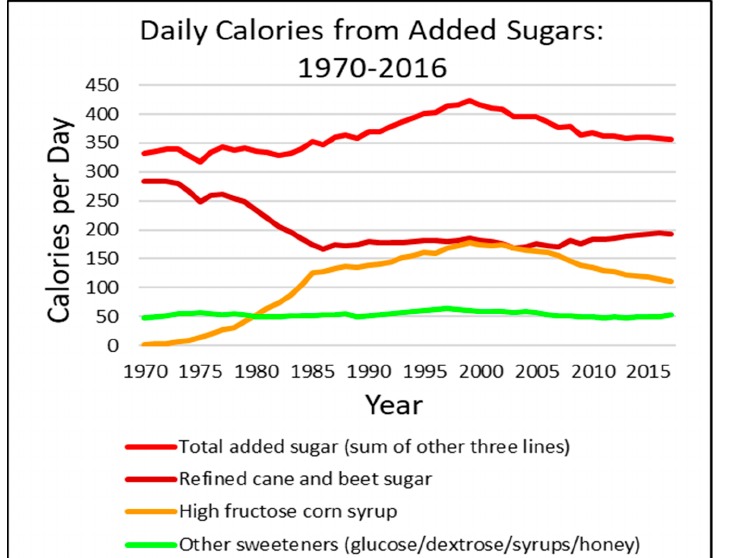
Figure 1. Average daily per capita calories from added sugars in the United States from 1970 through 2016. Food Availability (Per Capita) Data System; Loss-Adjusted Food Availability [5,8].